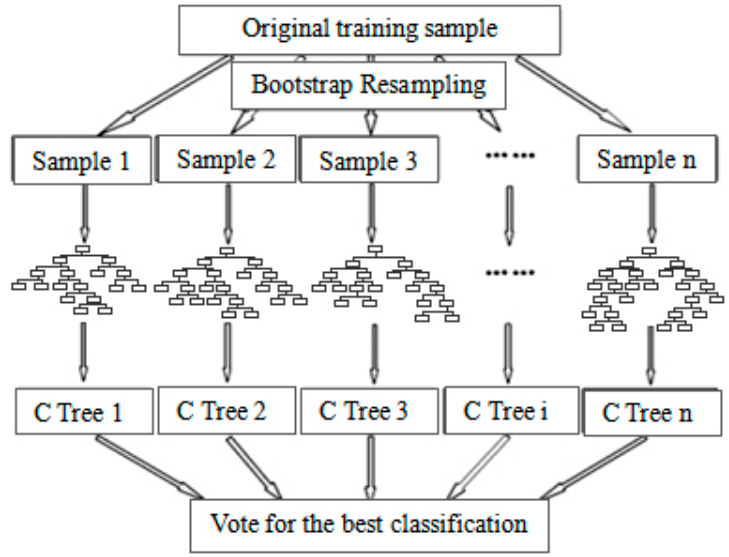
Figure 2. Random forest classifier. (n represents each sample size; C trees represents classification trees)